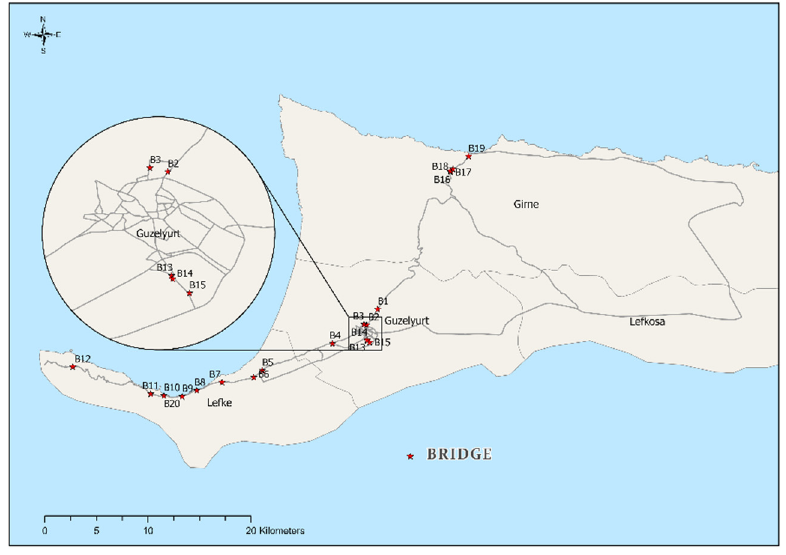
Figure 5. Bridge-link transportation network in the western part of Northern Cyprus.